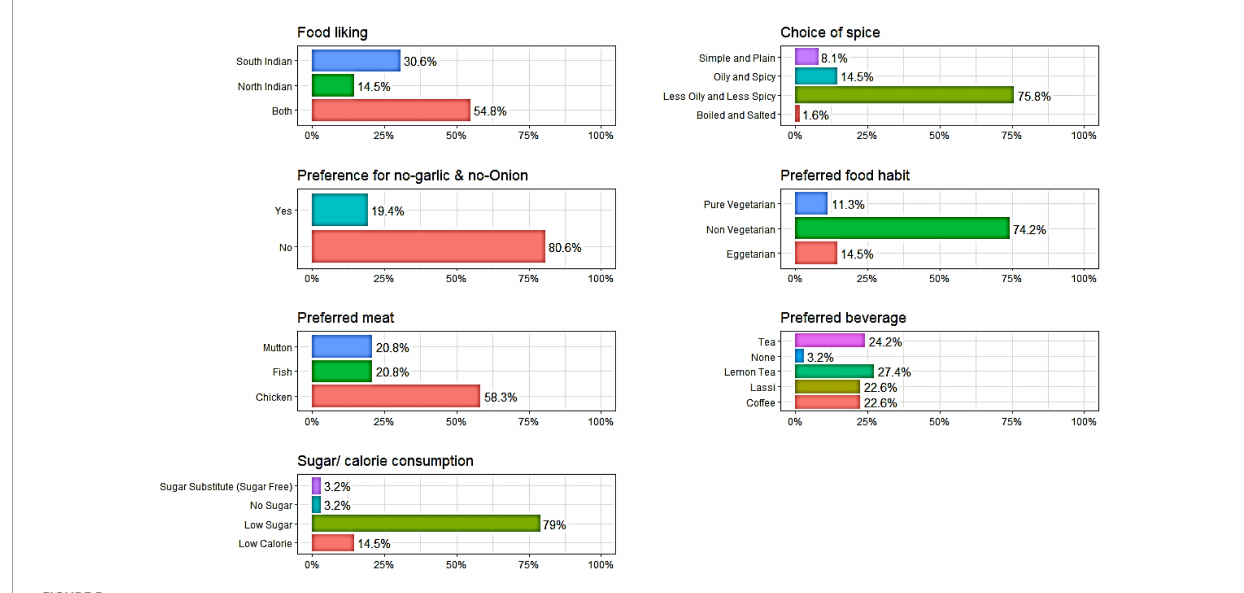
FIGURE5 A food planning chart for the various programmes at ICAR-NAARM.